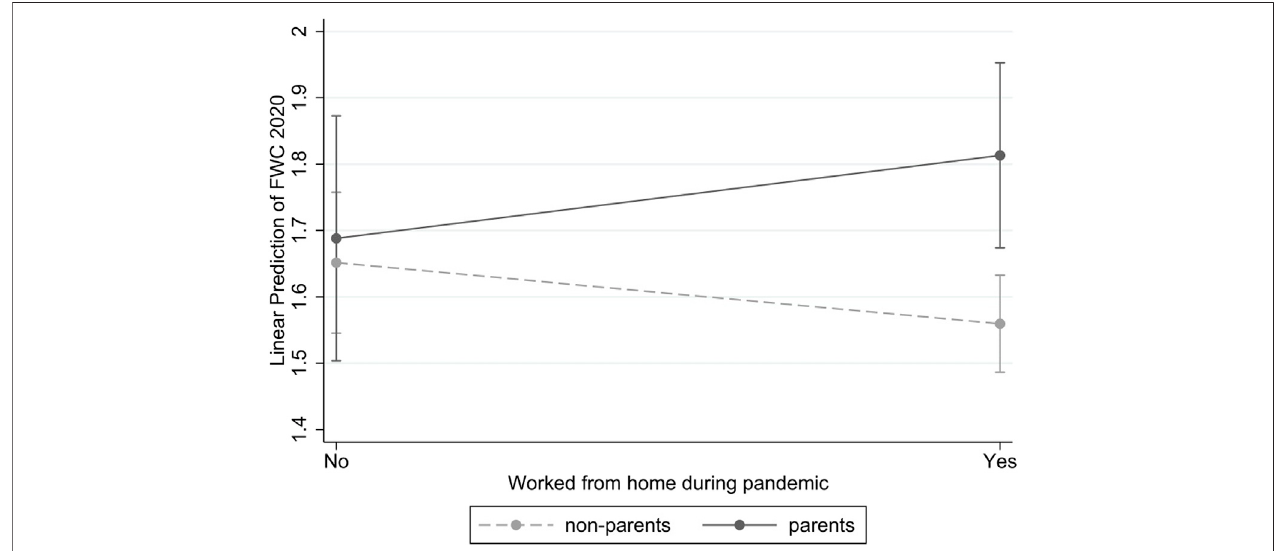
FIGURE 3 | Relationship between Parenthood Status and Working from Home during the Pandemic on Parents and Non-Parents FWC. Note: Results based on Model M1, in Table 7 . 90% con fi dence bands.